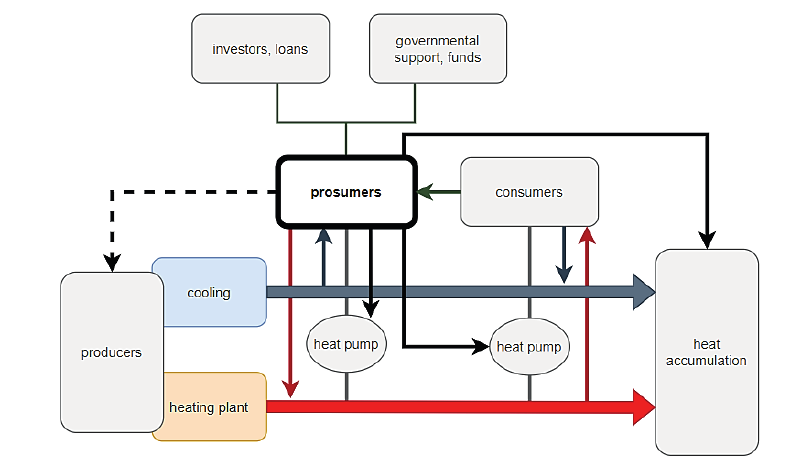
Fig. 4. Scheme of Scenario 2. Local Thermal Energy